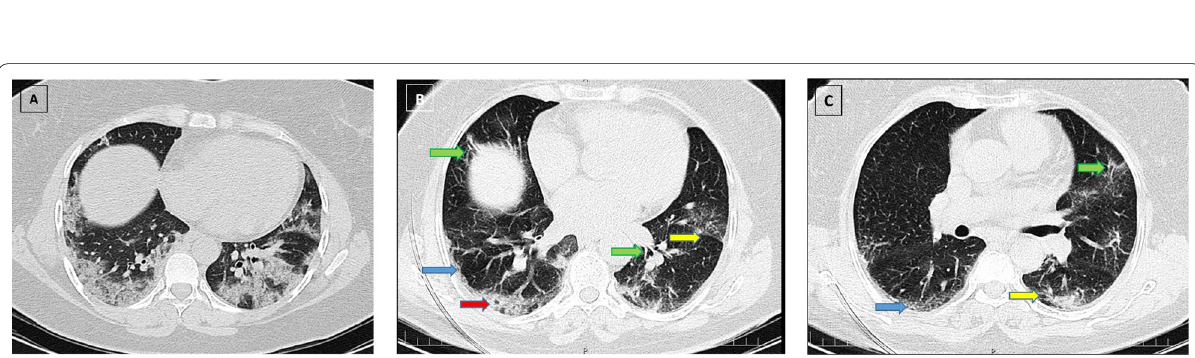
Fig. 4 A 47-year-old female patient presented with fever and cough, who was admitted to hospital and was discharged on day 16 of admission. Ground glass opacities and consolidations in multiple pulmonary lobes are observed in the initial CT scan ( A ). The total CT severity score was calculated as 18, and the disease severity was moderate. Three-month follow-up chest CT ( B ) shows a parenchymal band (yellow arrow), interlobular septal thickening (blue arrow), mild honeycombing (red arrow), and bronchiectasis (green arrows). Six-month follow-up chest CT ( C ) shows a few parenchymal bands (yellow arrow) and interlobular septal thickening (blue arrow) and mild bronchiectasis (green arrow), which was diminished in comparison to the previous CT